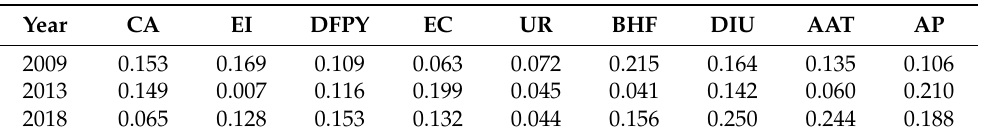
Table 4. Risk factor detection results in 2009, 2013, 2018.